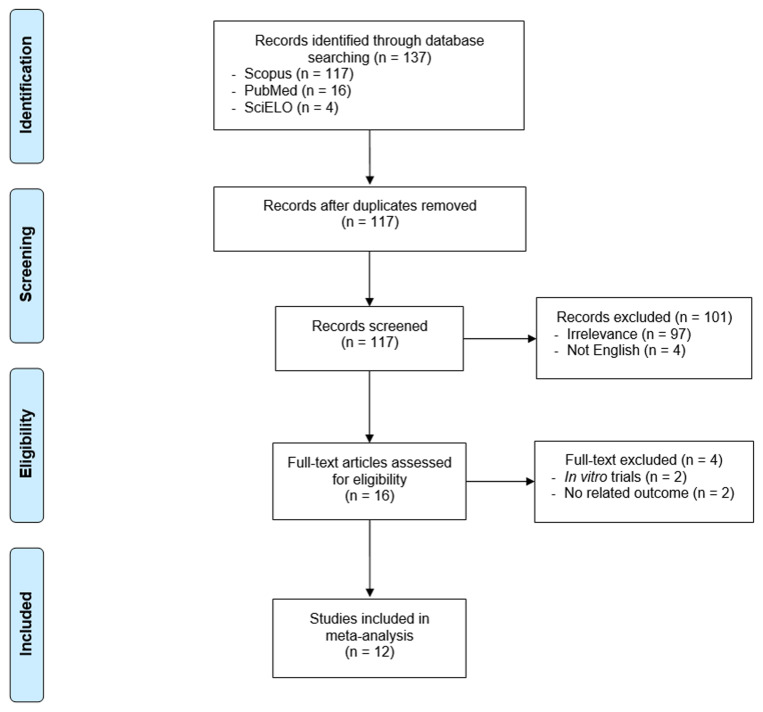
PRISMA flow diagram.